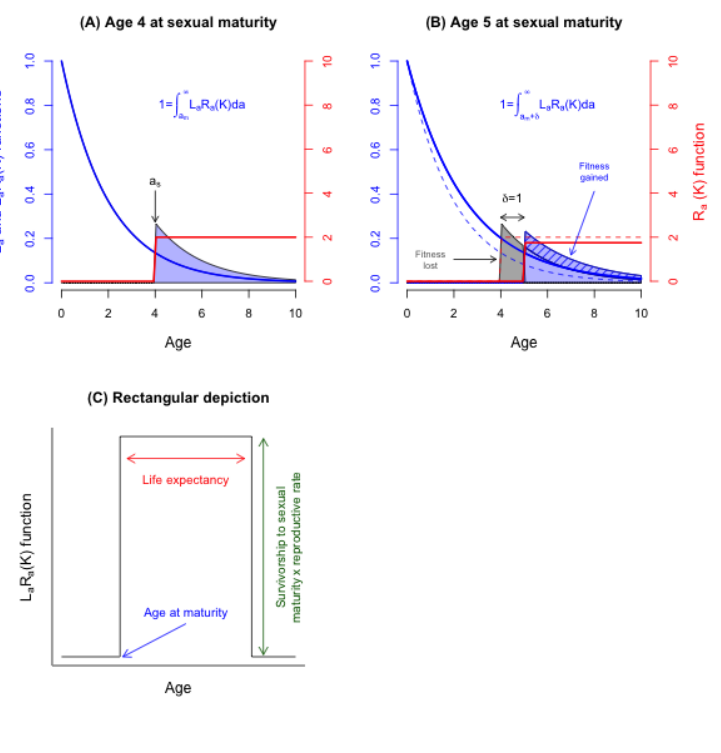
Figure 4. Summary of the age-structured life history dynamics of the model where reproduction is density-dependent. Blue lines represent the survivorship schedules (left y-axis) and red lines the fertility schedules (right y-axis). The polygons represent the product of the survivorship and reproduction schedules that are described with the equations. The initial life history strategy is depicted in (A), the mutant strategy, with a delayed age at sexual maturity, in (B). The delay in age at sexual maturity results in a change in the development function that results in an elevation of the survivorship function (compare the solid blue line in (B) to the solid blue line in (A) which is also represented by the dotted blue line in (B)). Because the volume of the blue polygon in (A) and (B) must equal one (equations on plot), the reproduction function is depressed in (B) compared to (A) (compare the solid red lines in (A) and (B)). The grey and hashed blue polygons in (B) show how the polygon has changed shape between the two life histories. (C) Rectangular approximation of the life history function used to identify